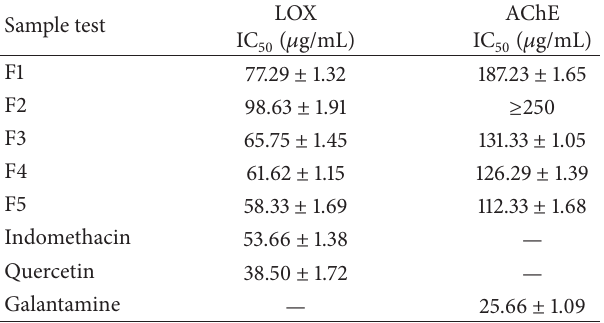
Table 2: In vitro enzyme inhibition potentials of flavone derivatives. Sample